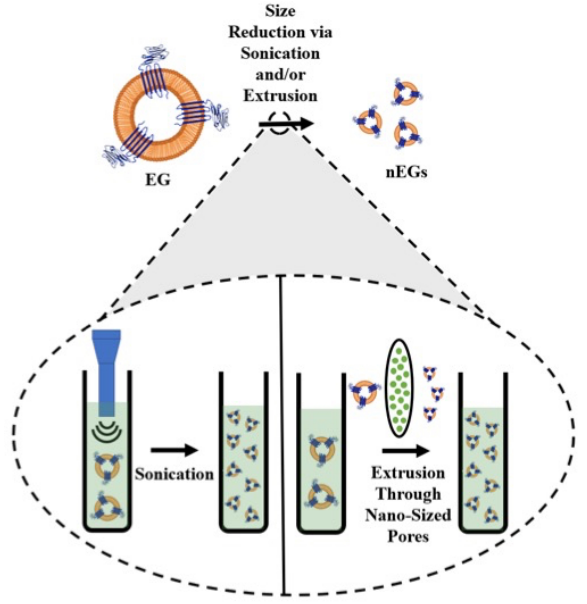
Figure 1. Schematic illustration of RBC membrane coating. RBCs are depleted of their hemoglobin using a hypotonic treatment to form erythrocyte ghosts (EGs). For illustration purposes, CD47 is shown as one of the RBC transmembrane proteins retained on EGs. The inset illustrates the sonication and extrusion size reduction methods. During sonication, sound waves are applied to EGs, while during extrusion, the EGs are pushed through filters with nano-sized pores, both of which result in formation of nEGs.